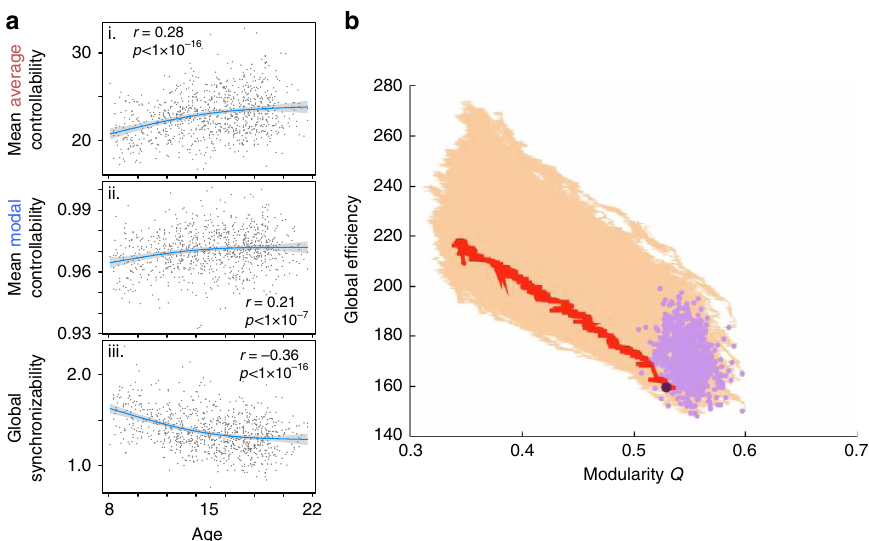
Fig. 8 Ruling out a dependence on modular structure in our results. a Linear fi ts when including the modularity Q index as a covariate, for plots of ( i ) mean average controllability, ( ii ) mean modal controllability, and ( iii ) global synchronizability, respectively — their relationships with age are barely changed. b The Pareto-optimization of brain networks for the metrics of modularity Q and global ef fi ciency does not display a similar functional form to the empirical data under these two metrics (the light purple dots). The simulated trajectories in the forward direction of these two metrics are shown in yellow. For illustration purposes, the large, dark purple dot and red trajectory indicate the result for a single